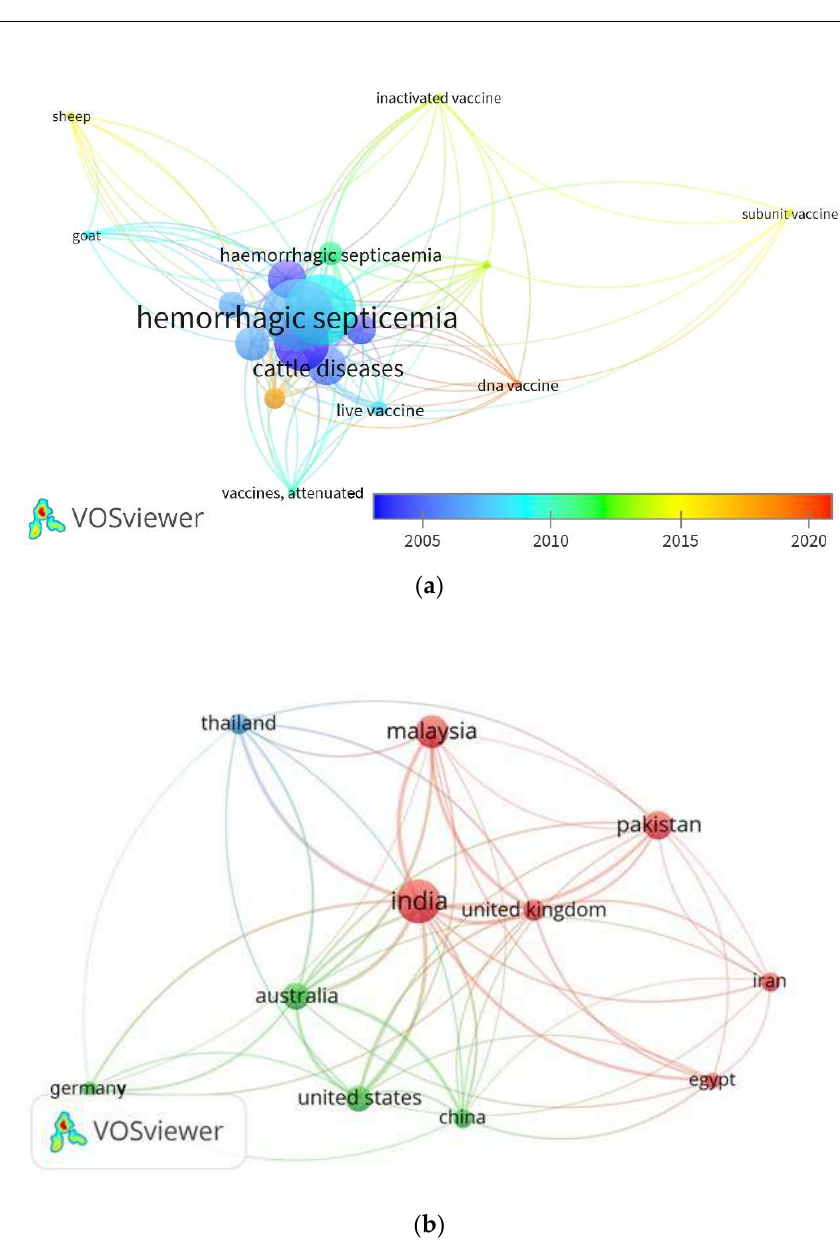
Figure 4. ( a ) The visualization map shows the trends in vaccine development against HS in the pe- riod between 2005 and 2020. ( b ) Visualization map shows the HS trends among the countries. between 2005 and 2020. ( b ) Visualization map shows the HS trends among the